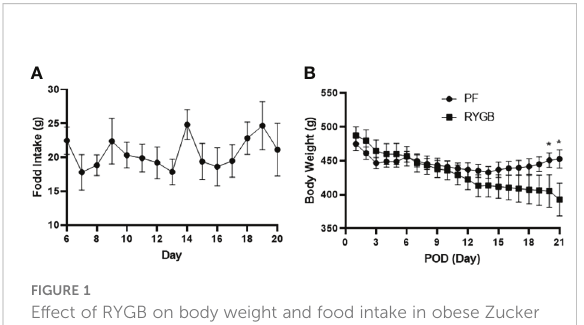
FIGURE 1 Effect of RYGB on body weight and food intake in obese Zucker rats. Body weight and food intake were monitored daily over 21- day study period after RYGB. (A) Daily mean food consumption (g/day) for the RYGB and PF groups. (B) Daily mean body weight (g) for the RYGB and PF groups. Data are mean ± SE, n=9-12 per group,